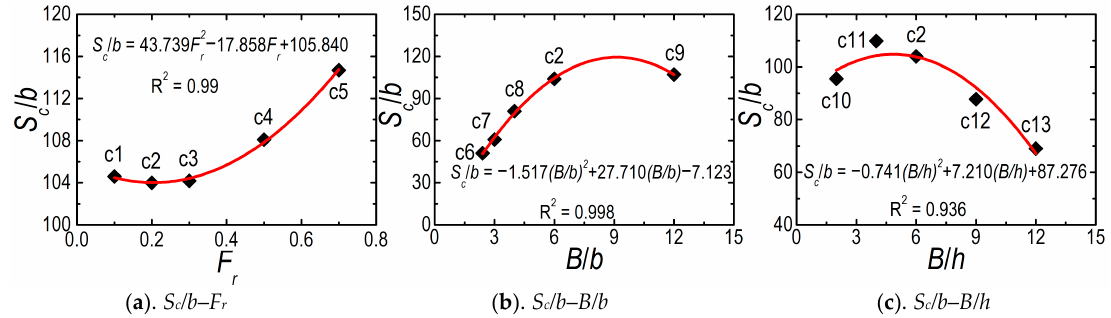
Figure 10. Relations of S c /b vs. F r , B/b and B/h. ( a ). Sc/b–Fr; ( b ). Sc/b–B/b; ( c ). Sc/b–B/h.